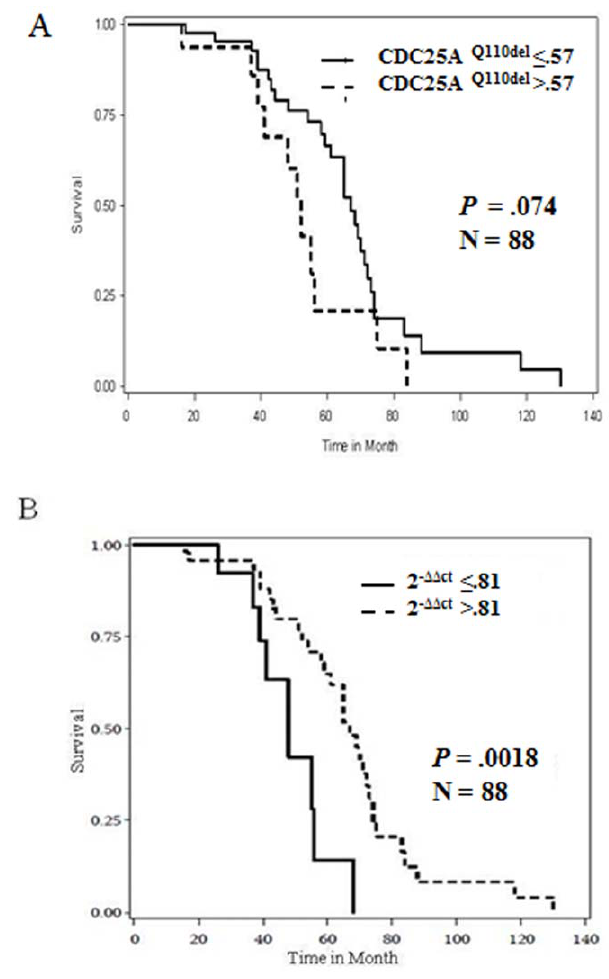
Figure 5. Clinical Significance of CDC25A Q110del . A. Kaplan Meier survival curves showed CDC25A Q110del in tumor tissue to correlate with poor overall survival of NSCLC patients (log rank P =.074). B. Kaplan Meier Survival curves showed that when CDC25A wt is higher in tumor versus normal tissue pair, it correlated with better overall survival (log rank P =.0018). Relative Quantification of target gene ‘‘CDC25A wt ’’ in NSCLC tumor tissue relative to normal tissue pair of NSCLC patients according to the formula: 2 2 DD ct . CDC25A template of tumor or normal was run in triplicates of uniplex reaction for each of the Ct wt and Ct tot assays, and the mean was calculated for each